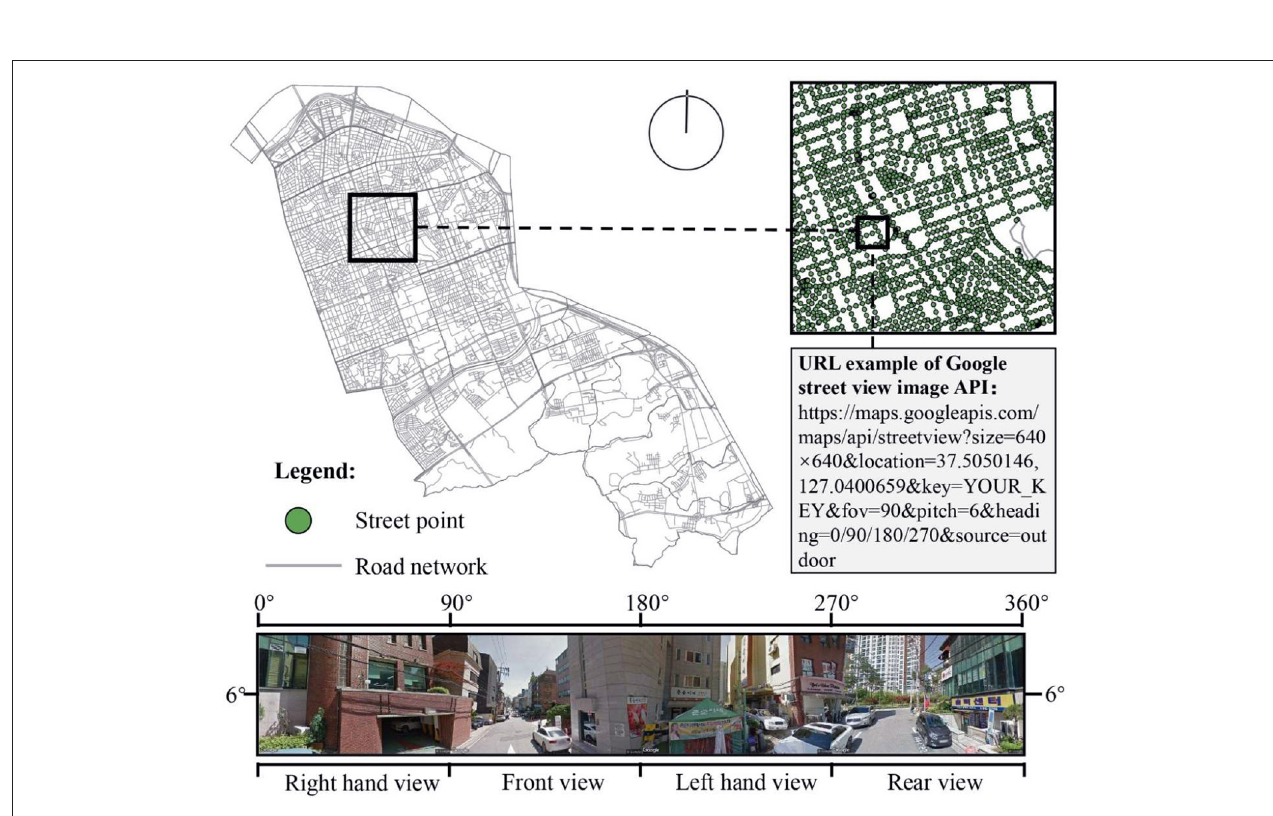
FIGURE 3 | Example of a panoramic street-view image using Google Maps API.